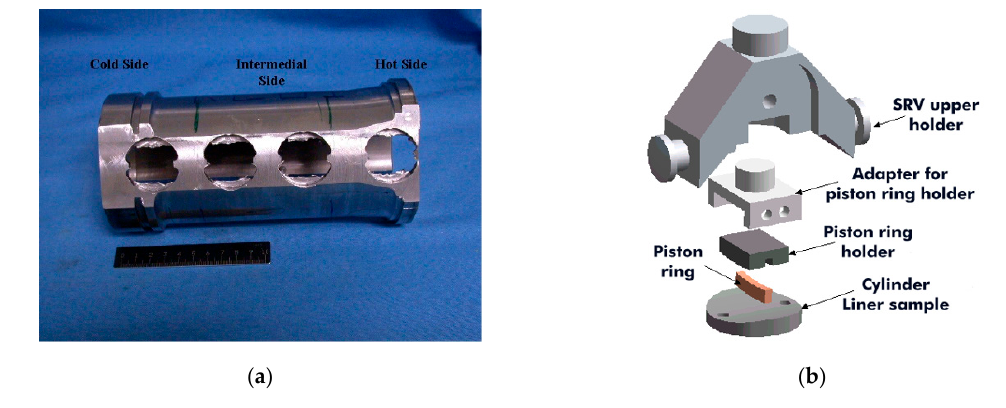
Figure 4. ( a ) Photo of the cylinder liner with cut outs made for tribological test samples. ( b ) Tribological